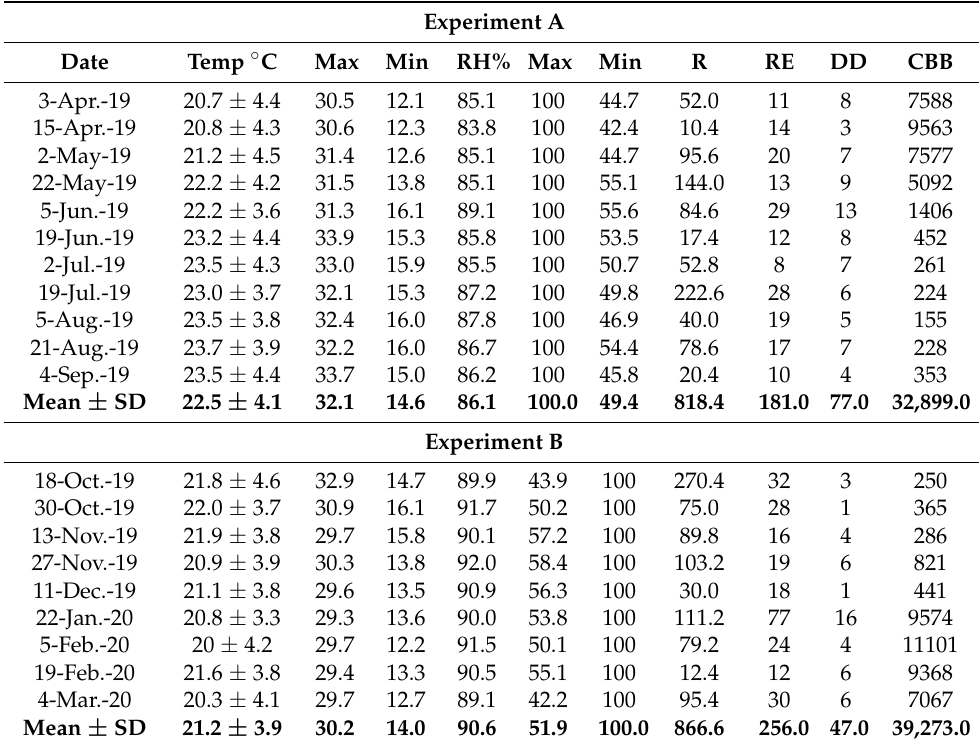
Table 1. Summary of environmental variables and total CBBs captured by the CTs at the study sites (Agricultural Experiment Station of the University of Puerto Rico, Adjuntas) showing the temperature (Temp ◦ C), relative humidity (RH%), and total rainfall (R) on the sampling date. R = rain (mm), RE = rain events, DD = dry